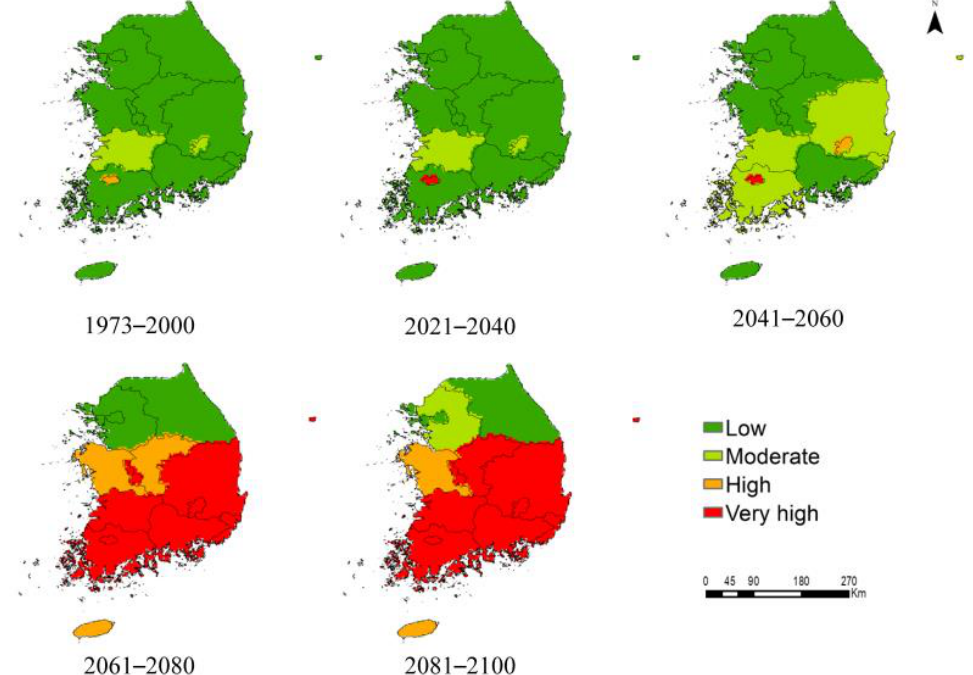
Figure 5. Mean habitat suitability for P. hysterophorus in different ADs of South Korea under the current climate (1973–2000) and future climate scenarios (SSP2-4.5; 2021–2040, 2041–2060, 2061–2080, and 2081–2100). The mean habitat suitability for P. hysterophorus was classified into four categories (low, moderate, high, and very high), each indicated with a different color.